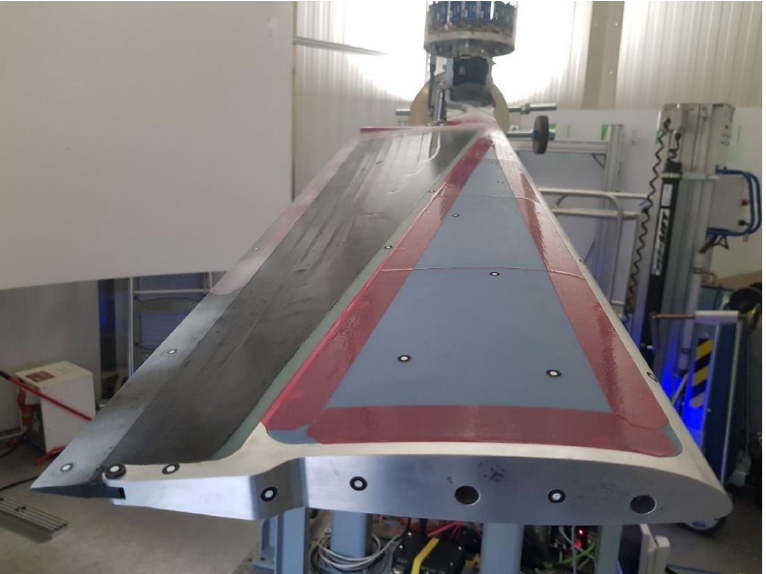
Figure 7. Complete demonstrator for chord morphing, installed in the test stand of the centrifugal